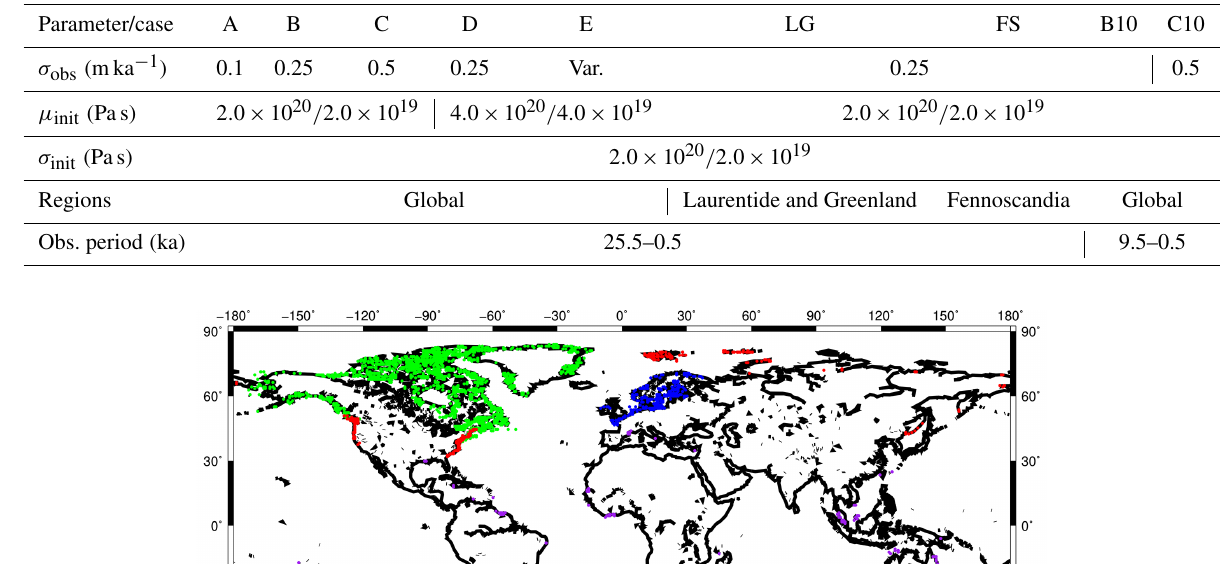
Table 2. Parameters of the test cases investigated, with the standard deviation of RSL observations ( σ obs ), mean, and standard deviation of ensemble perturbation at initialisation ( µ init and σ init ), regions from which observations were used, and the time interval of observations. Pairs of values represent lower/upper mantle viscosities. The observation uncertainty of case E is variable and decreases with time from 7 to 0.5mka − 1 , details in the text.